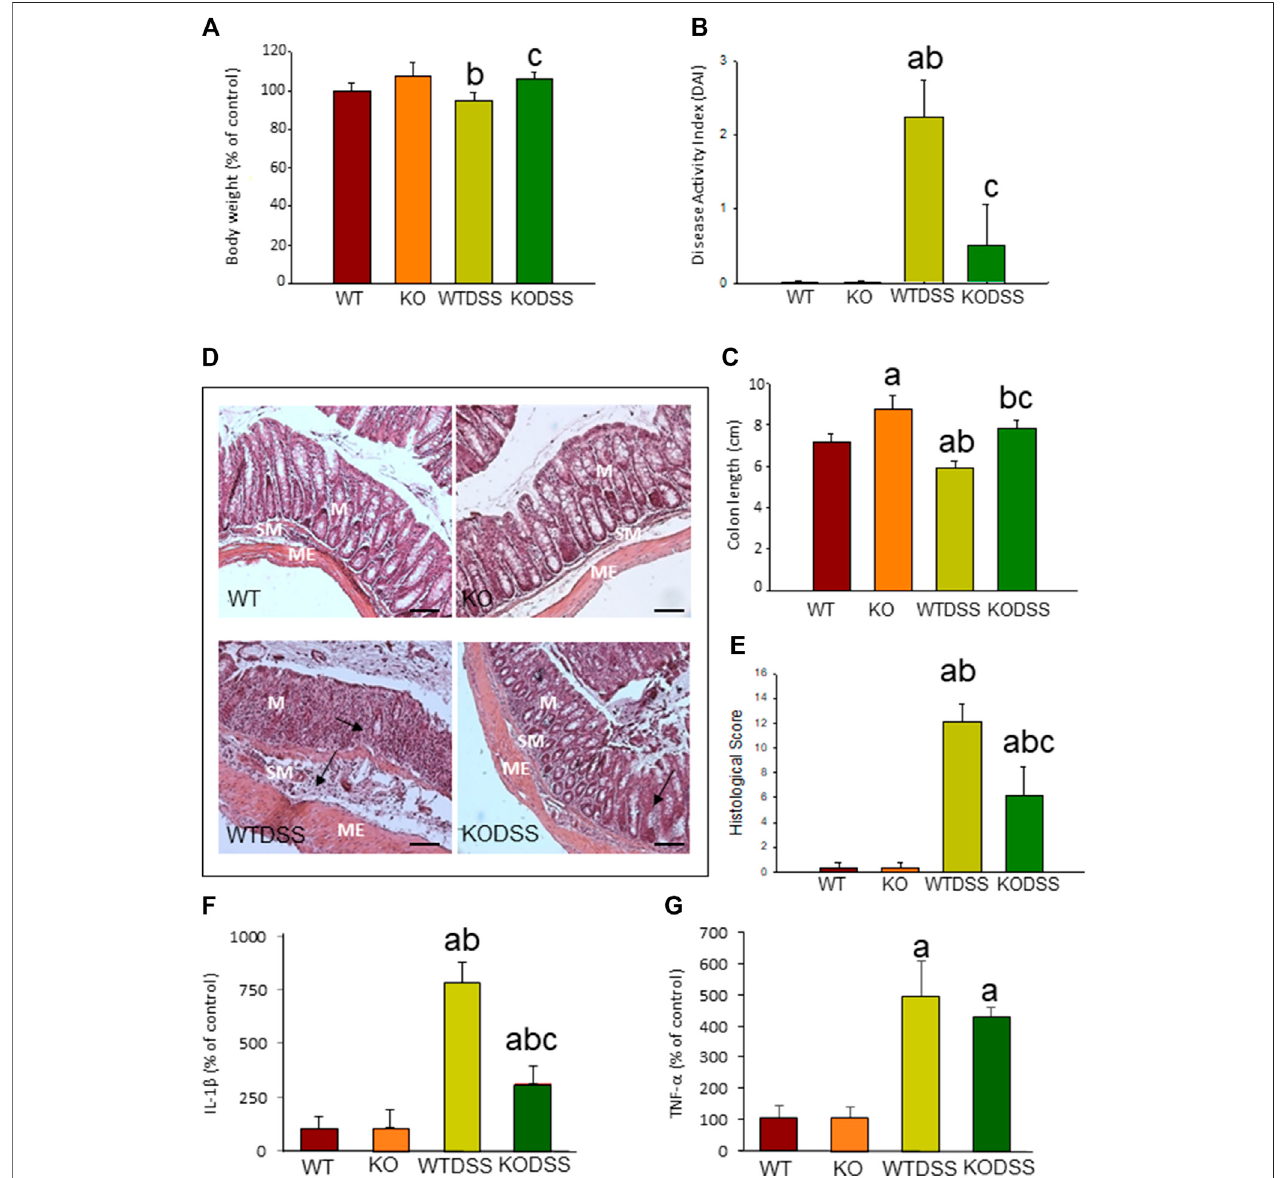
FIGURE 1 | Evaluation of the DSS-induced in fl ammation in WT and Gal3KO mice. The mice were subjected to 4 % DSS in the drinking water for up to 10 days. Clinical symptoms and indicators of colonic in fl ammation were assessed at the end of the treatment. Body weight expressed as percentage of control (WT mice) (A) ; disease activity index (DAI) (B) ; Length of colon (C) ; Representative photographs of histological analysis (D) performed with hematoxylin/eosin staining in distal colon sections. Scale bar: 200 µm. Alterations such as loss of structure of colonic crypts and in fi ltration of immune cells are indicated by arrows (M: mucosa; SM: submucosa;ME:muscularisexterna);Histologicalscore (E) ;mRNArelativeexpressionofIL-1 β (F) andTNF- α (G) indistalcolonexpressedaspercentageofcontrol(WT mice). Results are mean ± SD of 10 mice per experimental group. Statistical analysis: One-way ANOVA followed by the Fisher ’ s LSD post hoc test for multiple comparisons was used, with α (cid:2) 0.05: (a) , compared with the WT group; (b) , compared with the KO group; (c) , compared with the WTDSS group; p < 0.05 for body weight and mRNA expression, p < 0.001 for colon length, DAI and histological score. Abbreviations: WT, wild type mice; WTDSS, wild type mice treated with DSS; KO, Gal3 knockout mice; KODSS, Gal3 knockout mice treated with